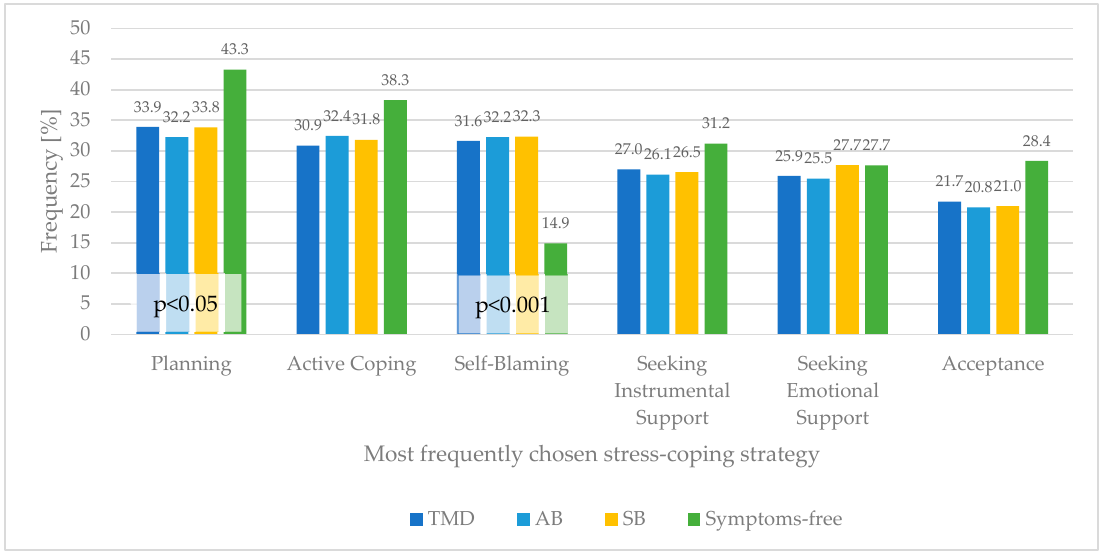
Figure 2. Frequency (percentage of subjects) of choosing most chosen coping strategies among subjects presenting TMD symptoms, possible AB and SB, and symptom-free.